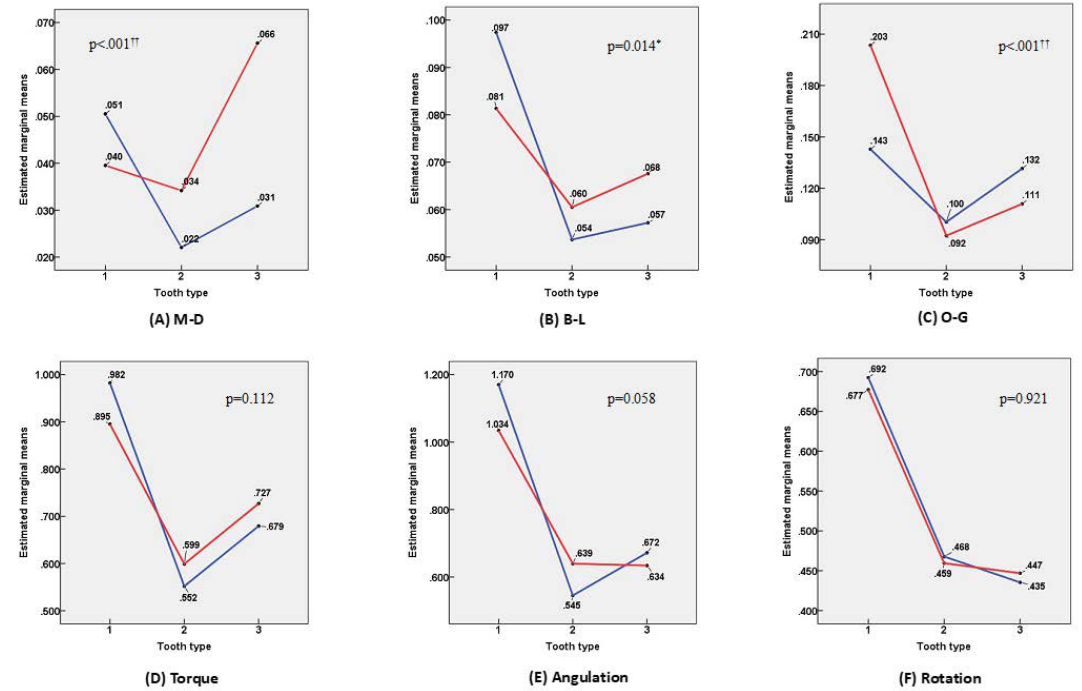
Figure 10. Profile plot for estimated marginal means of ( A ) M-D, ( B ) B-L, ( C ) O-G, ( D ) torque, ( E ) angulation, and ( F ) rotation. Tooth type 1, 2, and 3 represent six anterior teeth, premolars, and molars, respectively. The blue line represents the experimental group with resin base formed in advance, and the red line represents the group without resin